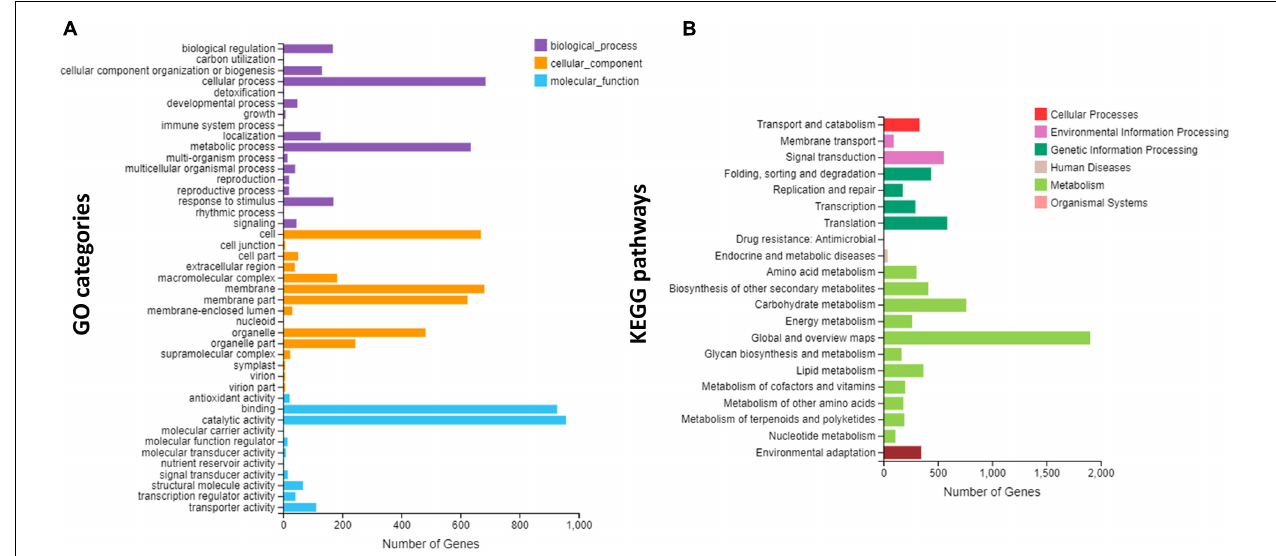
FIGURE 4 | Overview of Gene Ontology (GO) and Kyoto Encyclopedia of Genes and Genomes (KEGG) enrichments; (A) the GO enrichment, and (B) the KEGG enrichment.